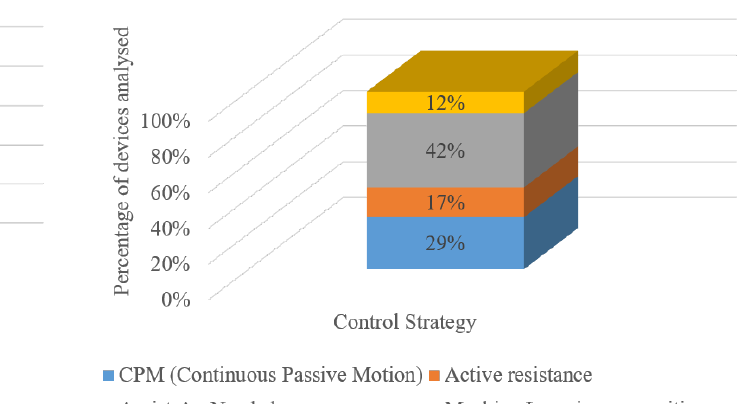
Figure 26. The percentage of wearable and portable wrist exoskeletons classified by sensing technolo- gies implemented and control strategies. Percentage have been used to report the device distribution since, usually, devices may have multiple sensors and control